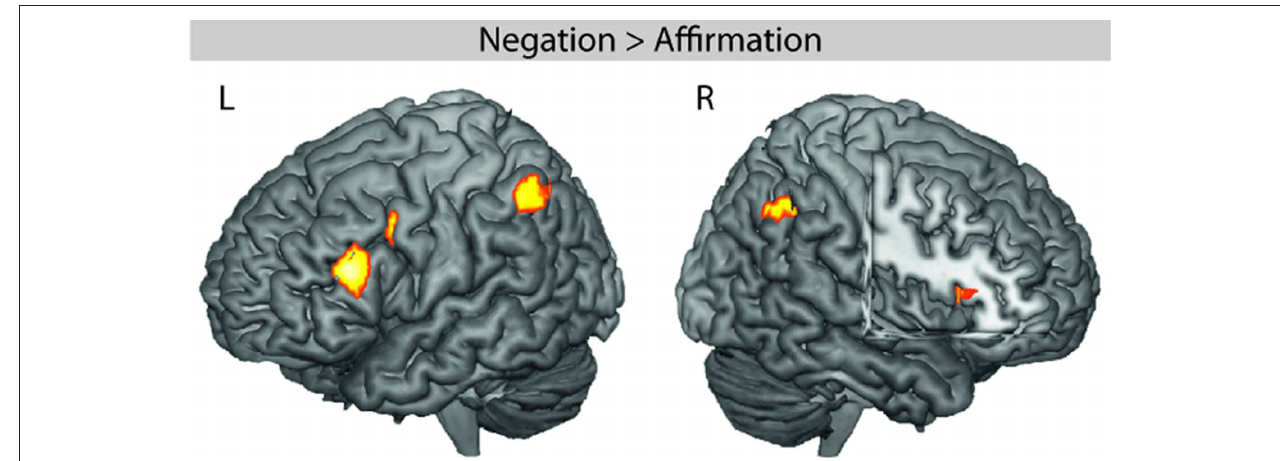
FIguRE 3 | fMRI effect of negation in the main clause. The whole-brain ANOVA revealed significant activity in the left inferior frontal gyrus (LIFG, BA 45), left inferior parietal lobule (LIPL), right angular gyrus (RAG), right anterior insula (RAI), and left precentral